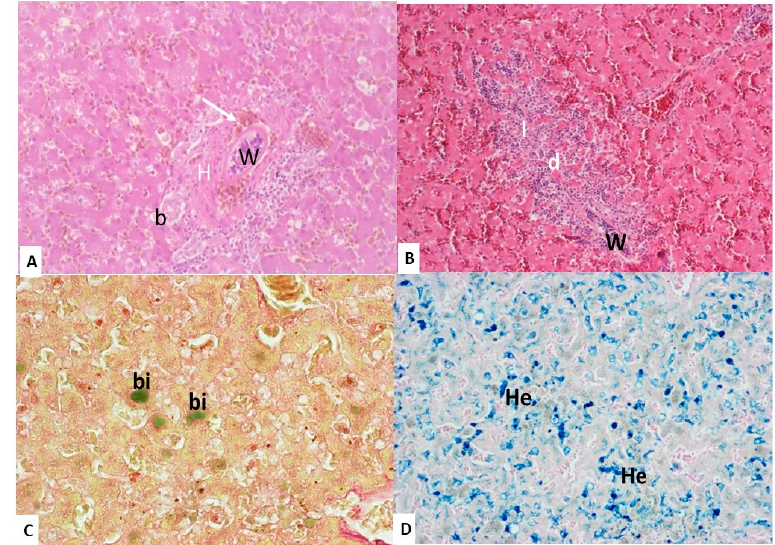
Figure 2. Effect of the parasite in the liver. ( A ) Adult worms (W) present in the thickened walled of the portal vein (H) with hemosiderin pigment deposition (white arrow) and bile duct hyperplasia (b). ( B ) Schistosome parasite (W) found in the hepatic sinusoids surrounded by degenerated hepatocyte (d) and massive inflammatory reaction (I). Hematoxylin and eosin stain (100 × ). ( C ) Emerald green–colored clumps of bile pigment (bi), Hall stain (400 × ). ( D ) Macrophages laden with bluish pigment (He), Berlin blue stain (100×).